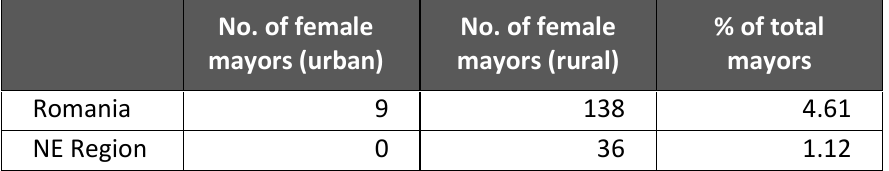
Table 1: The votes’ distribution for female mayors at the local elections in 2016 No. of female